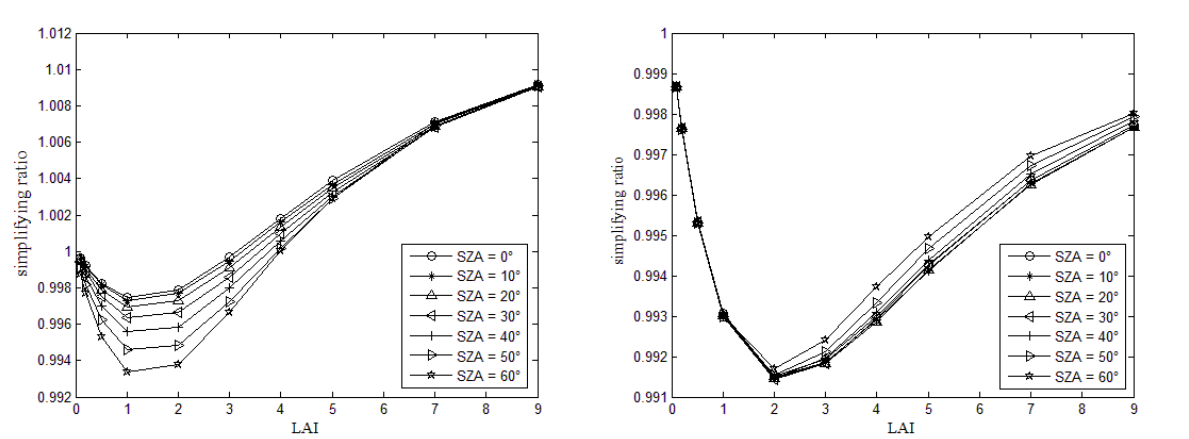
Figure 3. The ratio between the simplified value and the original value of av ( left ) and as ( right